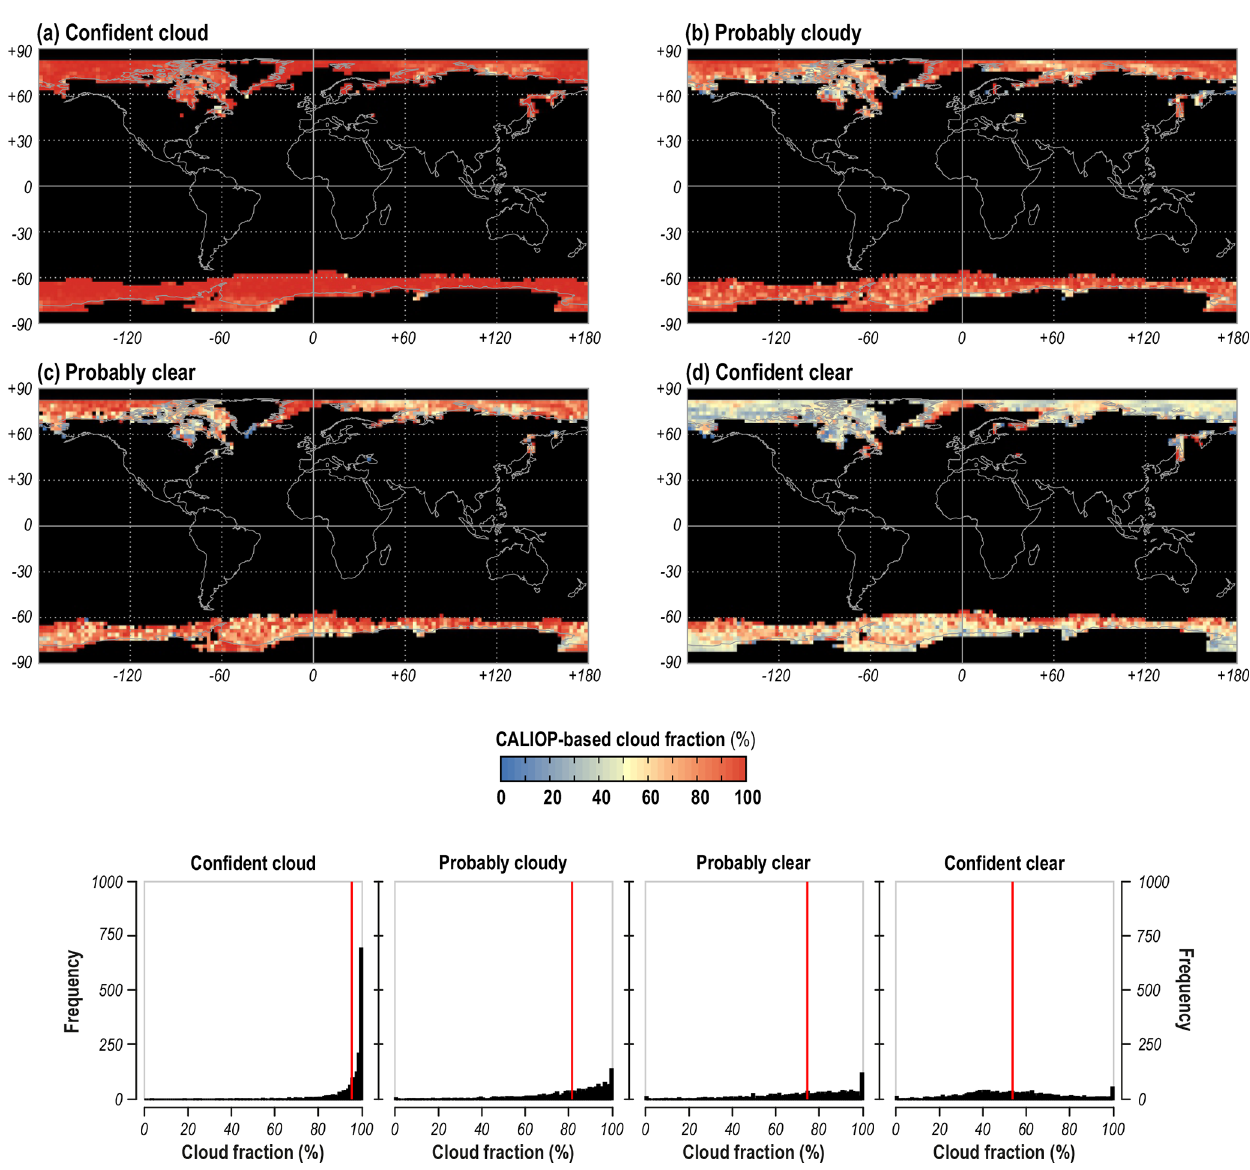
Figure 4. CALIOP-based cloud fraction for MODIS cloud mask classes for the “nighttime, snow(ice)-covered ocean” algorithm path and corresponding histograms (red vertical line indicates the mean